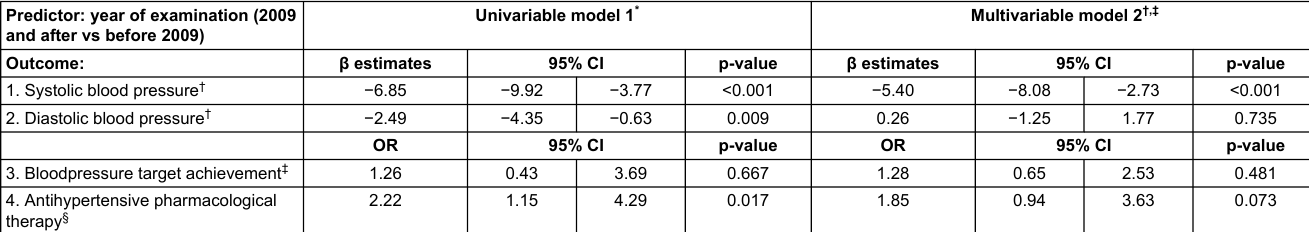
Table 3: Pooled multivariable mixed-effects regression results of guideline change (2009 and after vs. before 2009) predicting (1) systolic blood pressure, (2) diastolic blood pressure, (3) the likelihood of blood pressure target achievement and (4) the cumulative probability of pharmacological therapy type using imputed data in complicated hyperten- sion (n = 367).